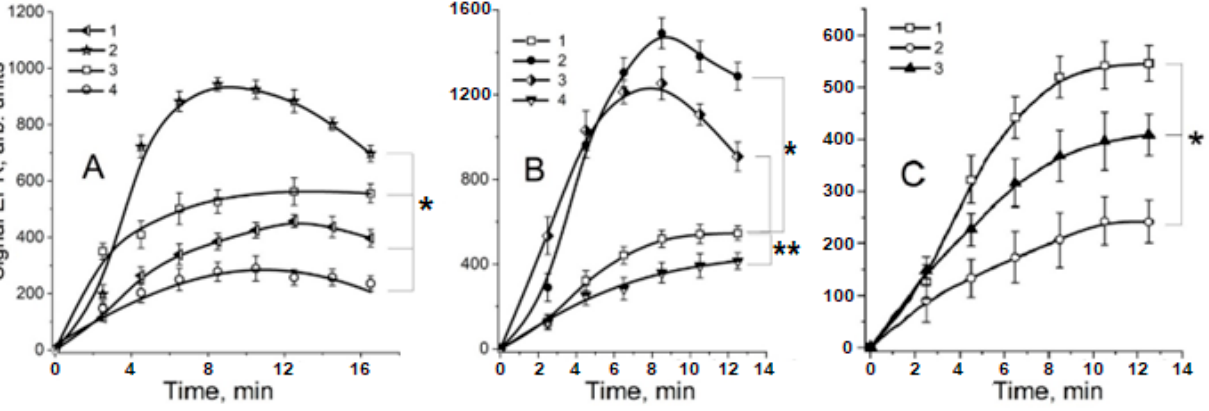
Figure 4. Kinetics of the formation of organic free radicals in the Maillard reaction. A—formation of free radical intermediates in the MG reaction with lysine. Reaction mixture: (1) − MG + lysine, both 100 mM; (2) − (1) + 4 mM S-nitrosoglutathione (GSNO); (3) − (1) + 4.8 mM PAPA NONOate; (4) − (1) + 4 mM Angeli’s salt. B—formation of free radical intermediates in the MG reaction with N α -acetyllysine. (1) − 160 mm MG + 160 mM N α -acetyllysine; (2) − (1) + 4 mM GSNO; (3) − (1) + 4 mM S-nitrosocysteine (CysNO); (4) − (1) + 1 mM DNICs containing reduced glutathione (GSH). C—inhibition of free radical production by nitroxyl anion and GSH. (1)—the same as B1; (2) − (1) + 1 mM Angeli’s salt; (3) − (1) + 4 mM GSH. EPR spectra were recorded 2.5 min after mixing the components. Modulation amplitude—0.4 mT. Results are depicted as the mean with S.E.M. of three independent experiments ( n = 3). ( A ) Two-way ANOVA (* p ≤ 0.05 for all point after 4 min). ( B ) Student t -test (* p ≤ 0.05 for all point after 2 min; ** p ≤ 0.05 for all point after 4 min). ( C ) Two-way ANOVA (* p ≤ 0.05 for all point after 4 min).